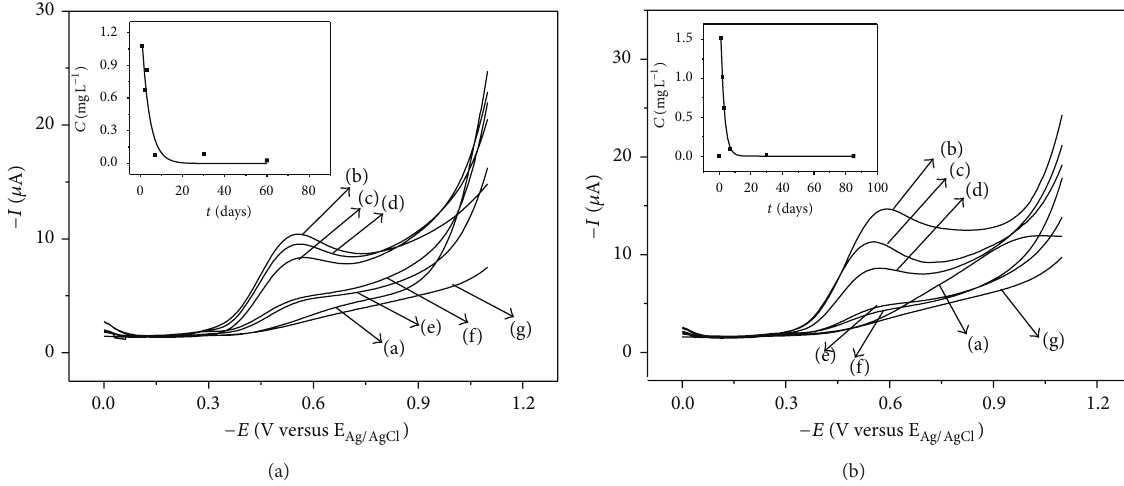
Figure 5: SWV curves for the 2,4-D herbicide in the two soil solution samples extracted at a 25 cm depth. (a) AM1 and (b) AM2. Parameters: = 0.03 V, 𝑡 𝑓 = 50s −1 , 𝑎 = 0.50 V, Δ𝐸 = 10s, and 𝐸 = − 0.40 V. Inset: decay of concentration with time. Samples: (a) sample without 𝑖 acc acc herbicide, (b) 24 hours, (c) 48 hours, (d) 72 hours, (e) 7 days, (f) 30 days, and (g) 60 days for AM1 and (a) sample without herbicide, (b) 24